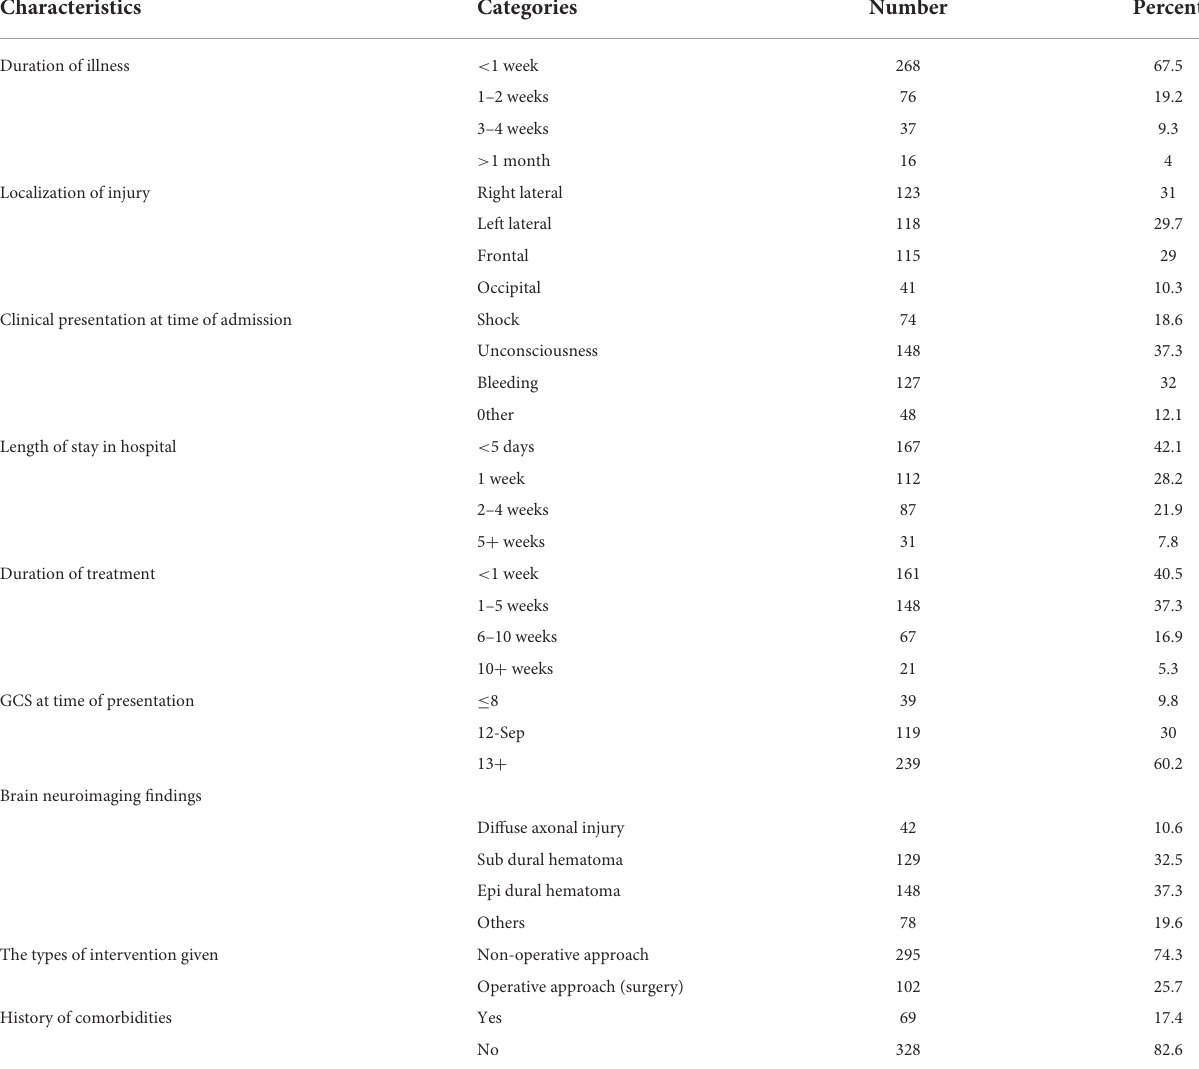
TABLE 2 Characteristics of injures of study participants attending emergency outpatient department of DTCH, Debre Tabor, Ethiopia ( n =